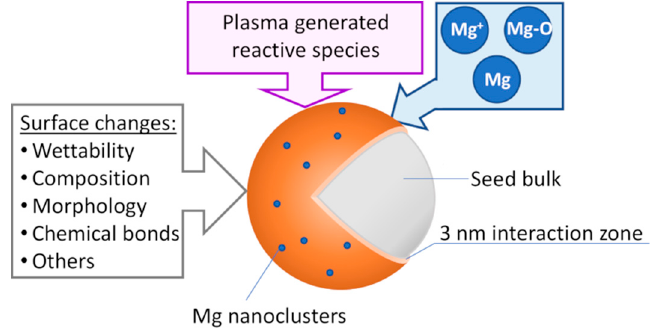
Figure 3. The scheme of the plasma treatment process with Mg nanoclusters deposition on the seed surface.